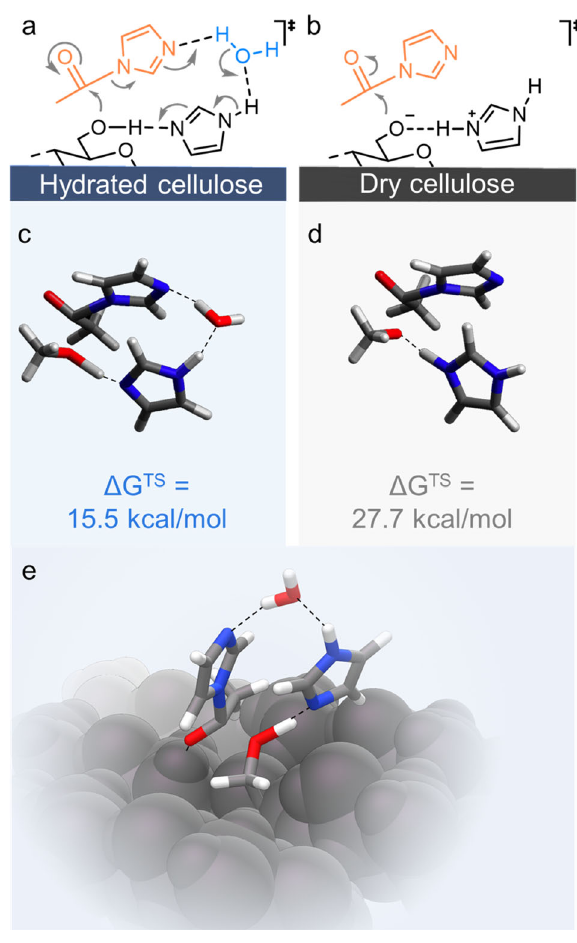
Fig. 5 Mechanism of the con fi ned water-promoted surface